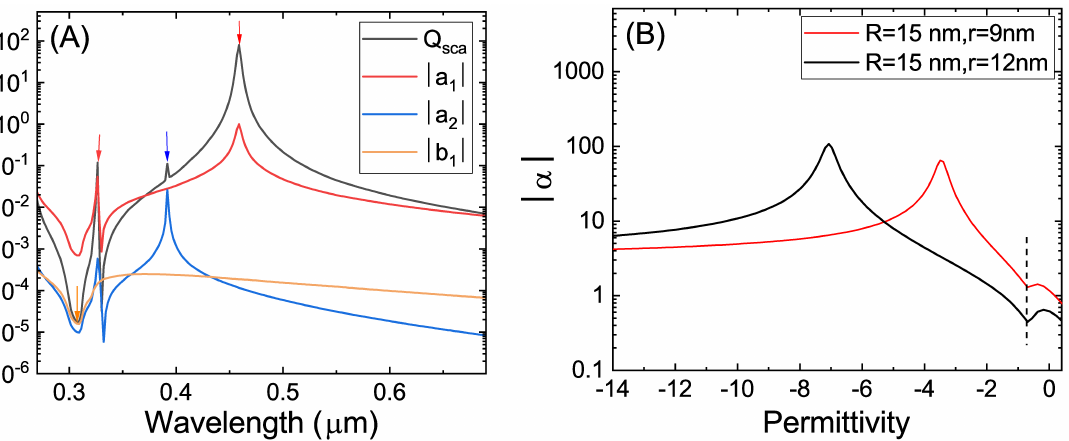
Figure 3. ( A ) The scattering efficiency for a hollow R = 20 nm vacuum@silver particle with core radius r = 16 nm (black line), and the Mie coefficients | a 1 | (red), | a 2 | (blue), and | b 1 | (orange). ( B ) The absolute value of the polarizability for two different core sizes of hollow vacuum@silver particles. The y axes of both plots are in logarithmic scale and the refractive index of the surrounding medium is